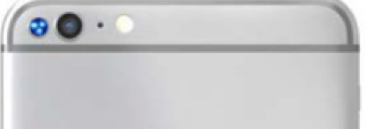
Figure 3. Passerby face is blurred thanks to nonrecording database or toggle setting.